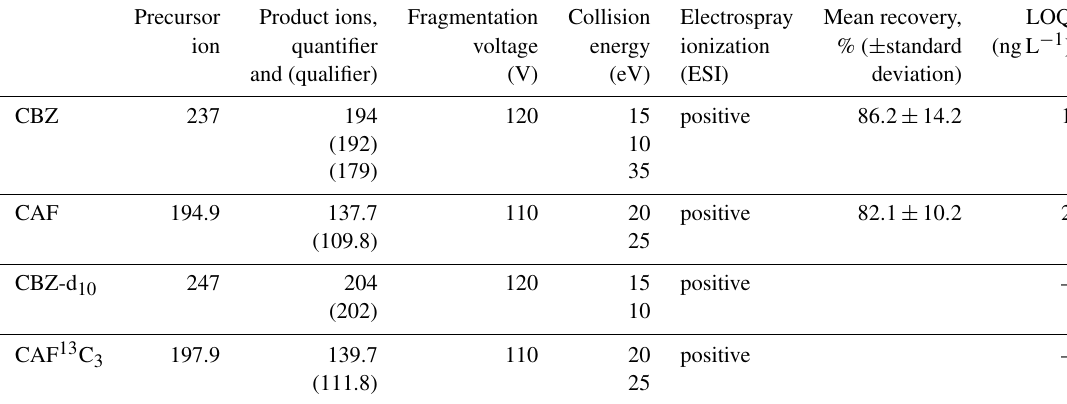
Table 1. LC/MS/MS method main characteristics for CBZ and CAF. Precursor Product ions, Fragmentation Collision Electrospray Mean recovery, ion